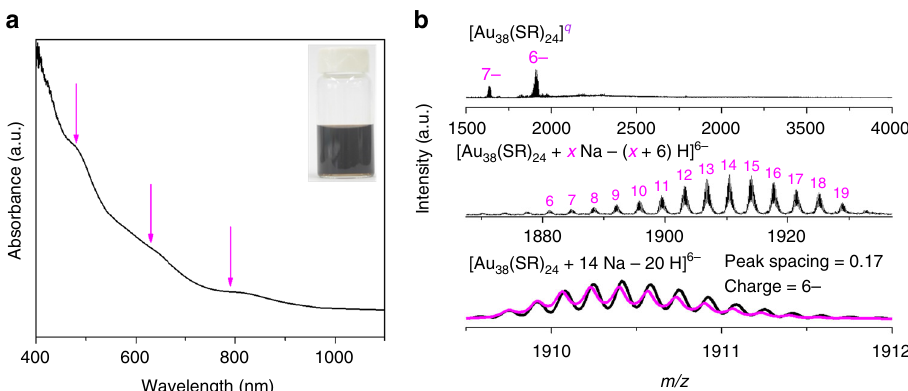
Fig. 7 Seed-mediated synthesis of [Au 38 (SR) 24 ] 0 . a Ultraviolet-visible absorption and b electrospray ionization mass spectra of [Au 38 (SR) 24 ] 0 . The inset in a is digital photo of an aqueous solution of [Au 38 (SR) 24 ] 0 . The absorption features at 480, 630, and 790 nm in a are in good agreement with the most prominent absorption of organic-soluble [Au 38 (SR) 24 ] 0 with a fused bi-icosahedral Au 23 core 52 . The magenta and black lines in bottom spectra of b show the simulated and experimental isotope patterns of [Au 38 (SR) 24 +14 Na – 20 H] 6 − ,